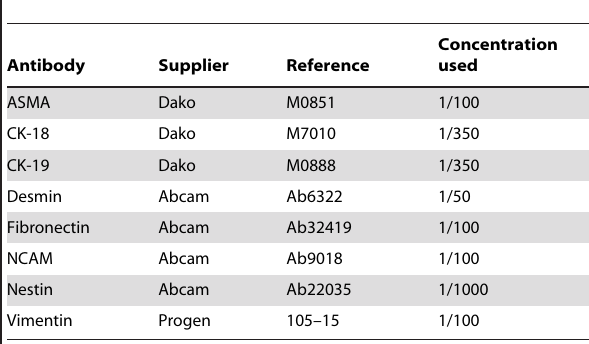
Table 2. Primary antibodies used for the phenotypic characterization of ADHLSC and HSC by immunocytochemistry & western blotting.